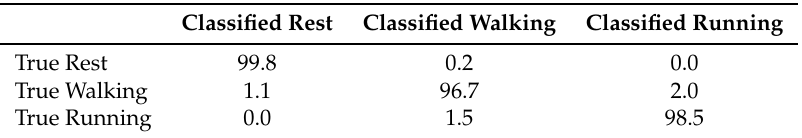
Table 4. Confusion matrix, using the smart annotation model (SA-GZ4), of continuous data including walking, running and rest on a per sample basis. All calculated per person and then per class and displayed as a percentage.